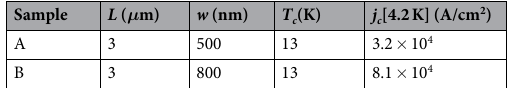
Table 1. Parameters of the nanostrips.